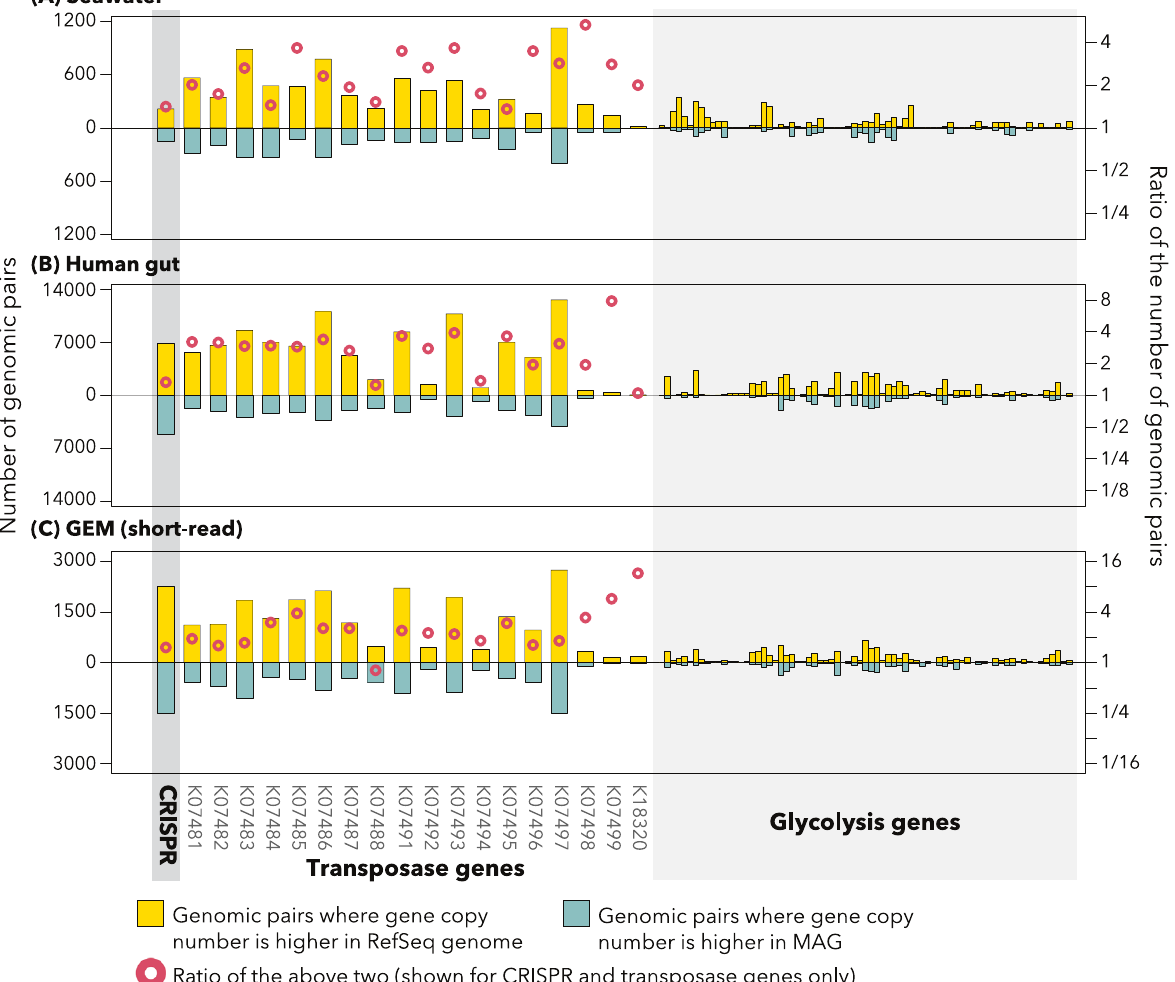
Fig. 5 Distribution of CRISPR, transposase genes, and glycolysis genes among phylogenetically close MAGs and RefSeq genomes. The number of CRISPRs or each ortholog was counted for each MAG and phylogenetically close RefSeq genome pair. A yellow or blue bar indicates the number of pairs where the RefSeq genome or the MAG had a higher number of CRISPRs (or the ortholog), respectively (left axis). A red circle (for CRISPRs and transposase genes only) represents the ratio of these two (the former divided by the latter) (right axis, log scale). Three panels indicate the results for three different MAG datasets: seawater ( A ), the human gut ( B ), and the GEM ( C